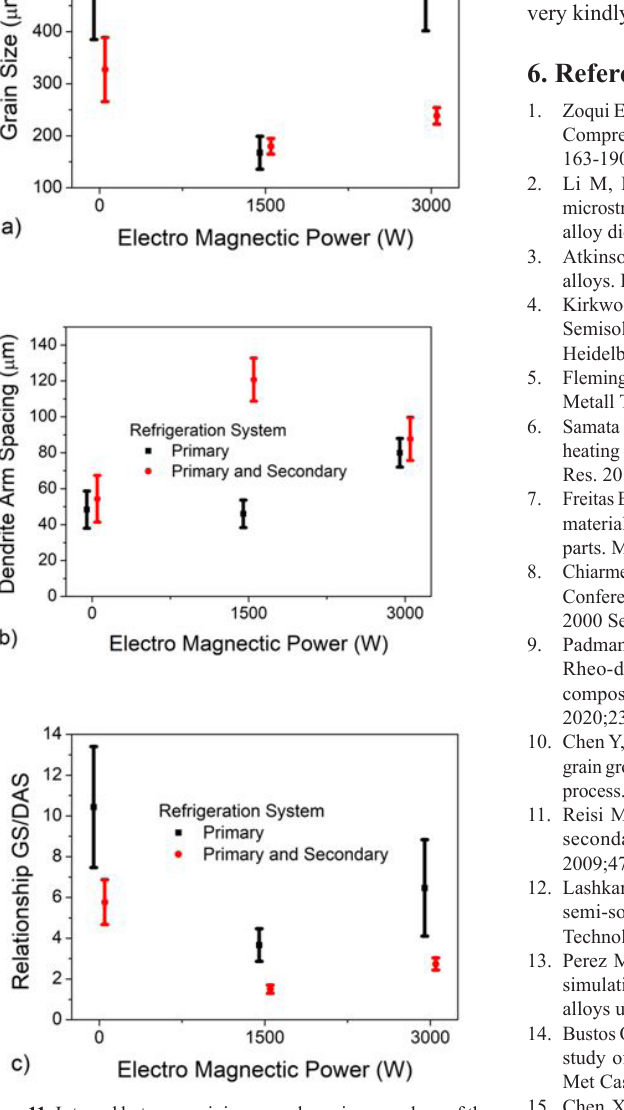
Figure 11. Interval between minimum and maximum values of the microstructural parameters GS (a), DAS (b) and GS/DAS (c) for ingots cast by route 4 with PC (black) and PSC (red) and stirred at 0, 1500 and 3000 W. The values in the graphs correspond to the average and overall standard deviation of the values for the distal, medial and proximal regions in Table